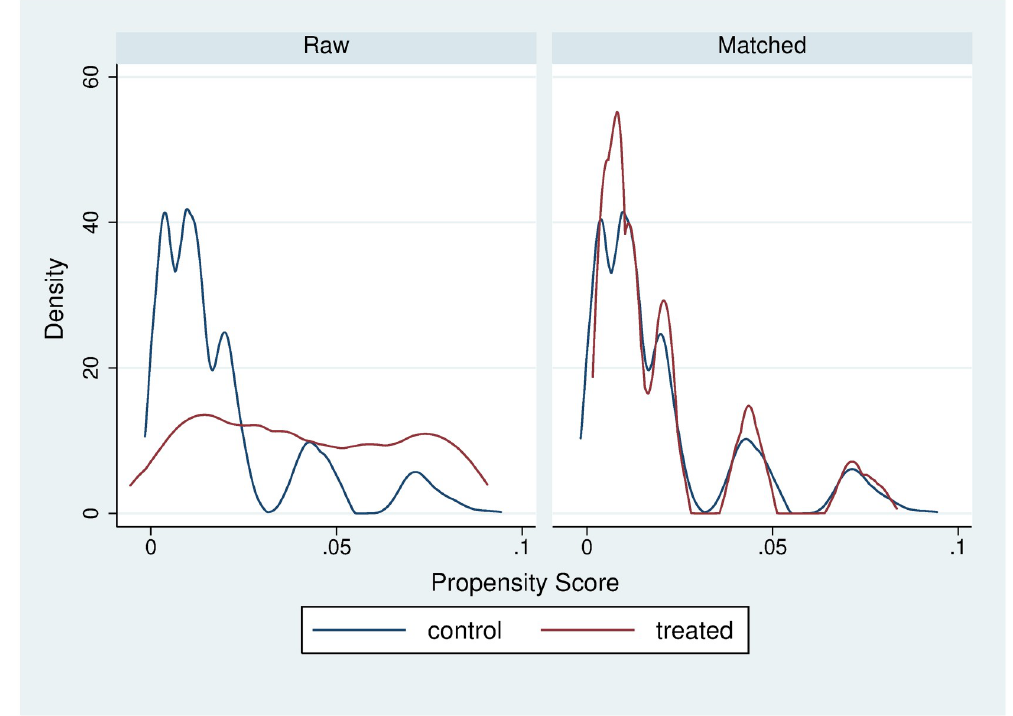
Fig 1. 6-nearest neighbor weight matching